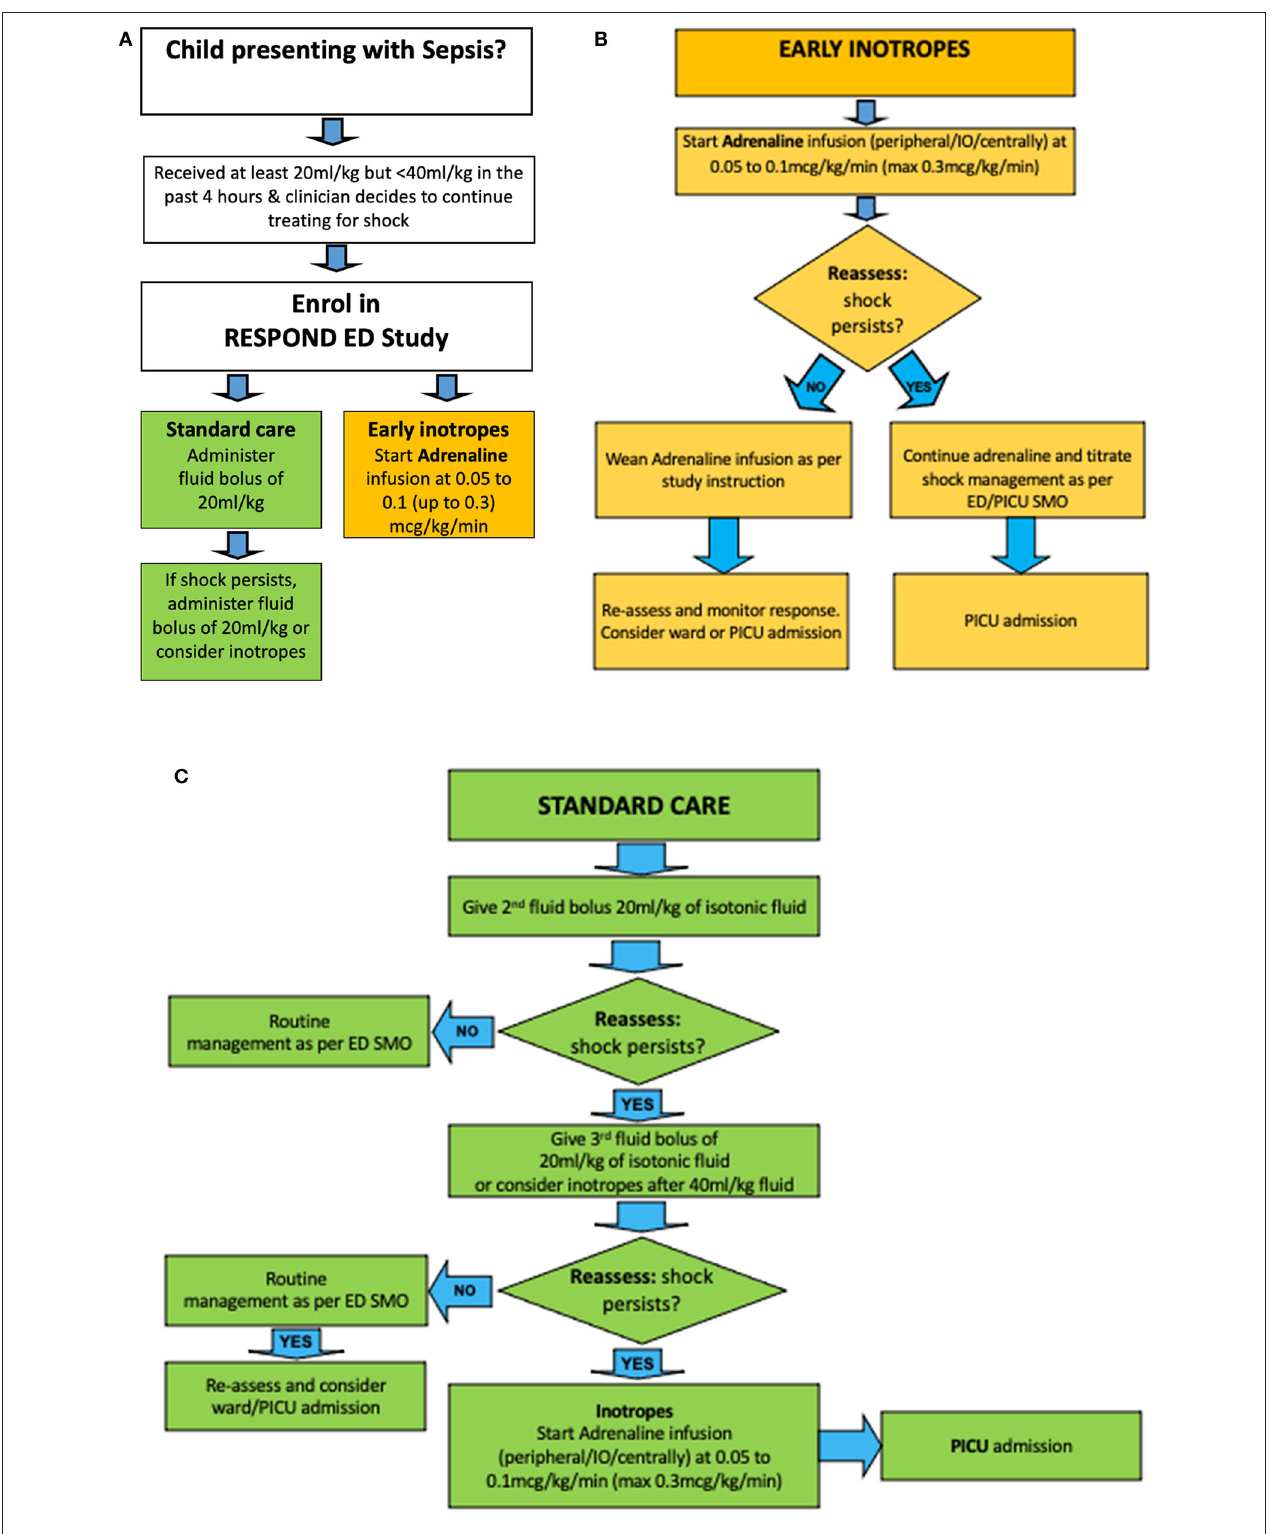
FIGURE 2 | Treatment algorithm for RESPOND ED. Children with sepsis having received an initial fluid bolus are randomized (A) to early inotropes , defined as initiation of adrenaline infusion after 20 ml/kg fluid bolus (B) , vs. standard care , defined as provision of 40–60 ml/kg fluid boluses before inotropes are started (C) . ED SMO, Emergency Department Senior Medical